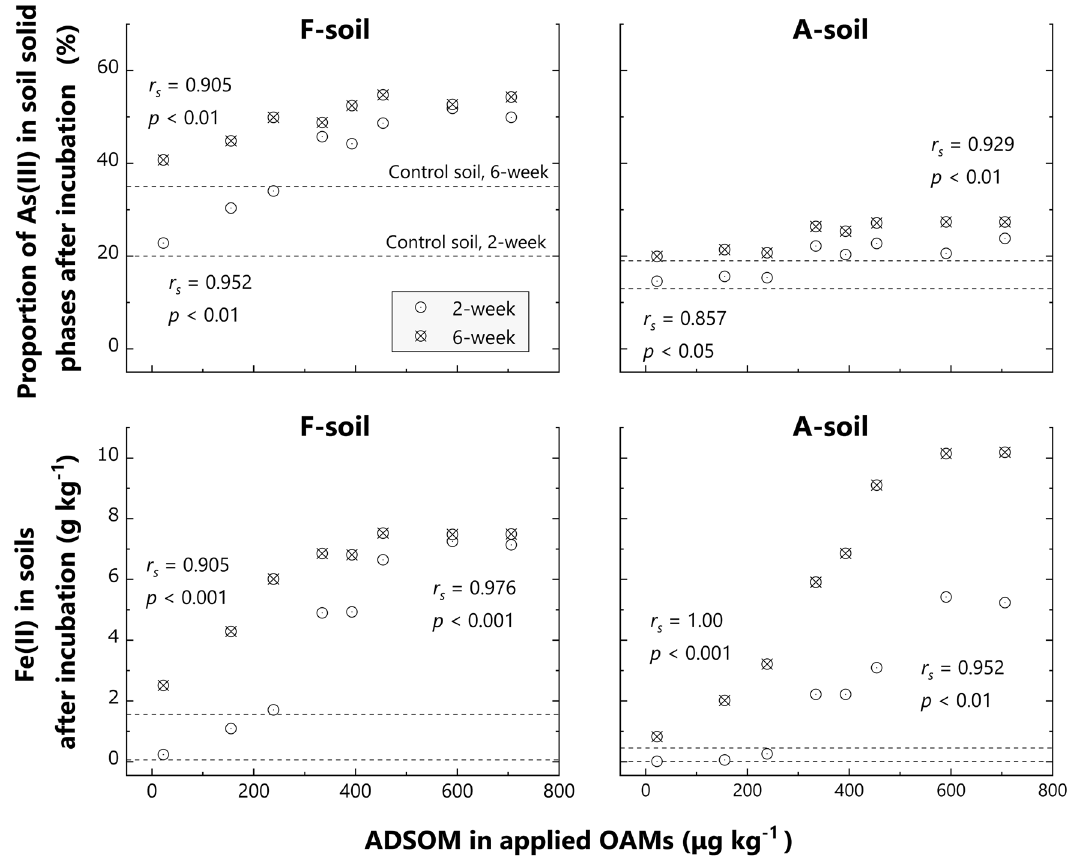
Figure 6. Relationship between acid-detergent soluble organic matter (ADSOM) in applied organic amendments (OAMs), proportion of As(III) in solid phases (upper layers) of soils, and Fe(II) contents in soils (lower layers) after 2- and 6-week incubation. The soil samples were with or without selected OAMs (2, 5, 9, 10, 13, 14, 19 and 23). The proportion of As(III) or Fe(II) content in control soils is indicated by a dotted line in each incubation time for comparison: the upper line is the 2-week incubation, and the lower is the 6-week incubation. Data are shown as the average of duplicates. r s denotes Spearman’s rank correlation coefficient.